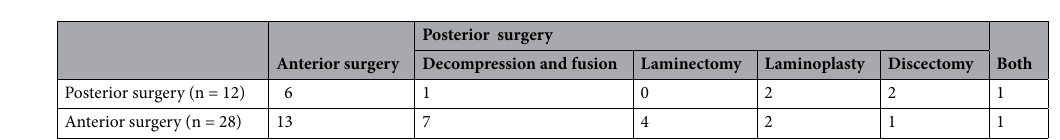
Table 3. Surgical method for additional